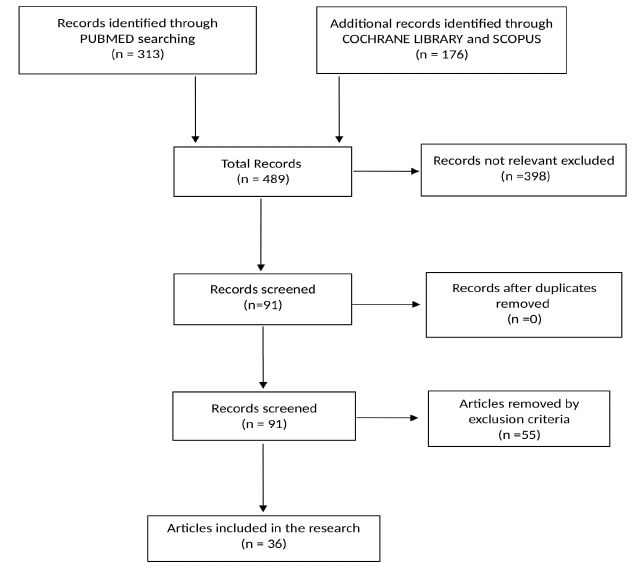
Figure 1. Flow chart of the bibliographic research.